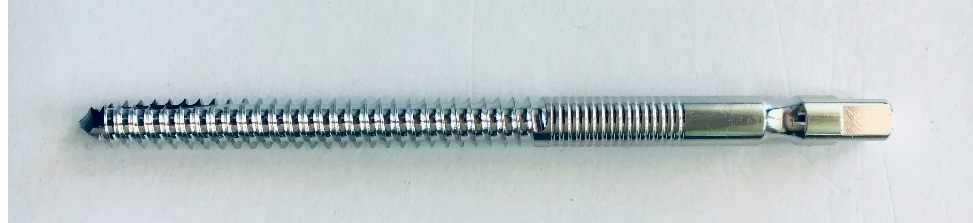
Figure 4. Apex pin with a diameter of 6 mm.